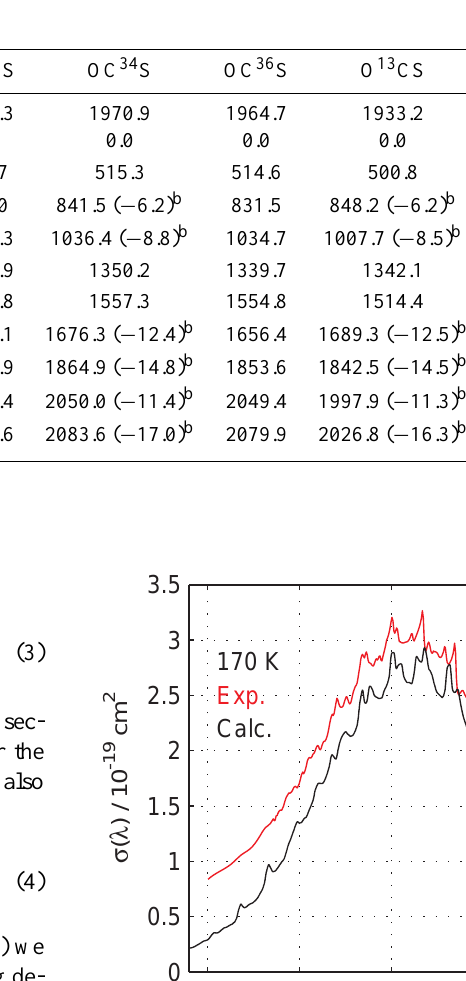
= E i − E ( 0 , 0 , 0 ) . The numbers in parenthesis i